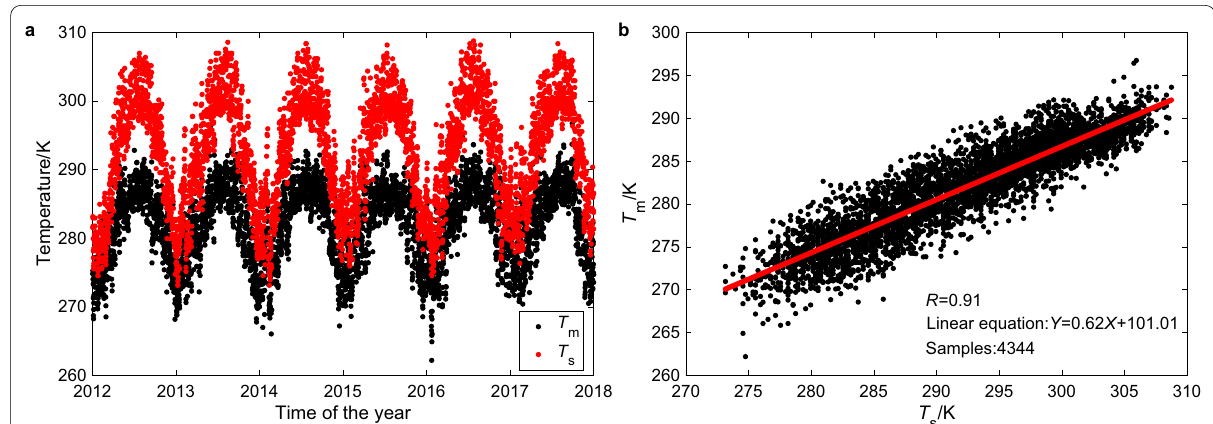
Fig. 4 Relationship between T m and T s from the radiosonde data from 2012 to 2017. a T m and T s time series, b correlation plot between T m and T s